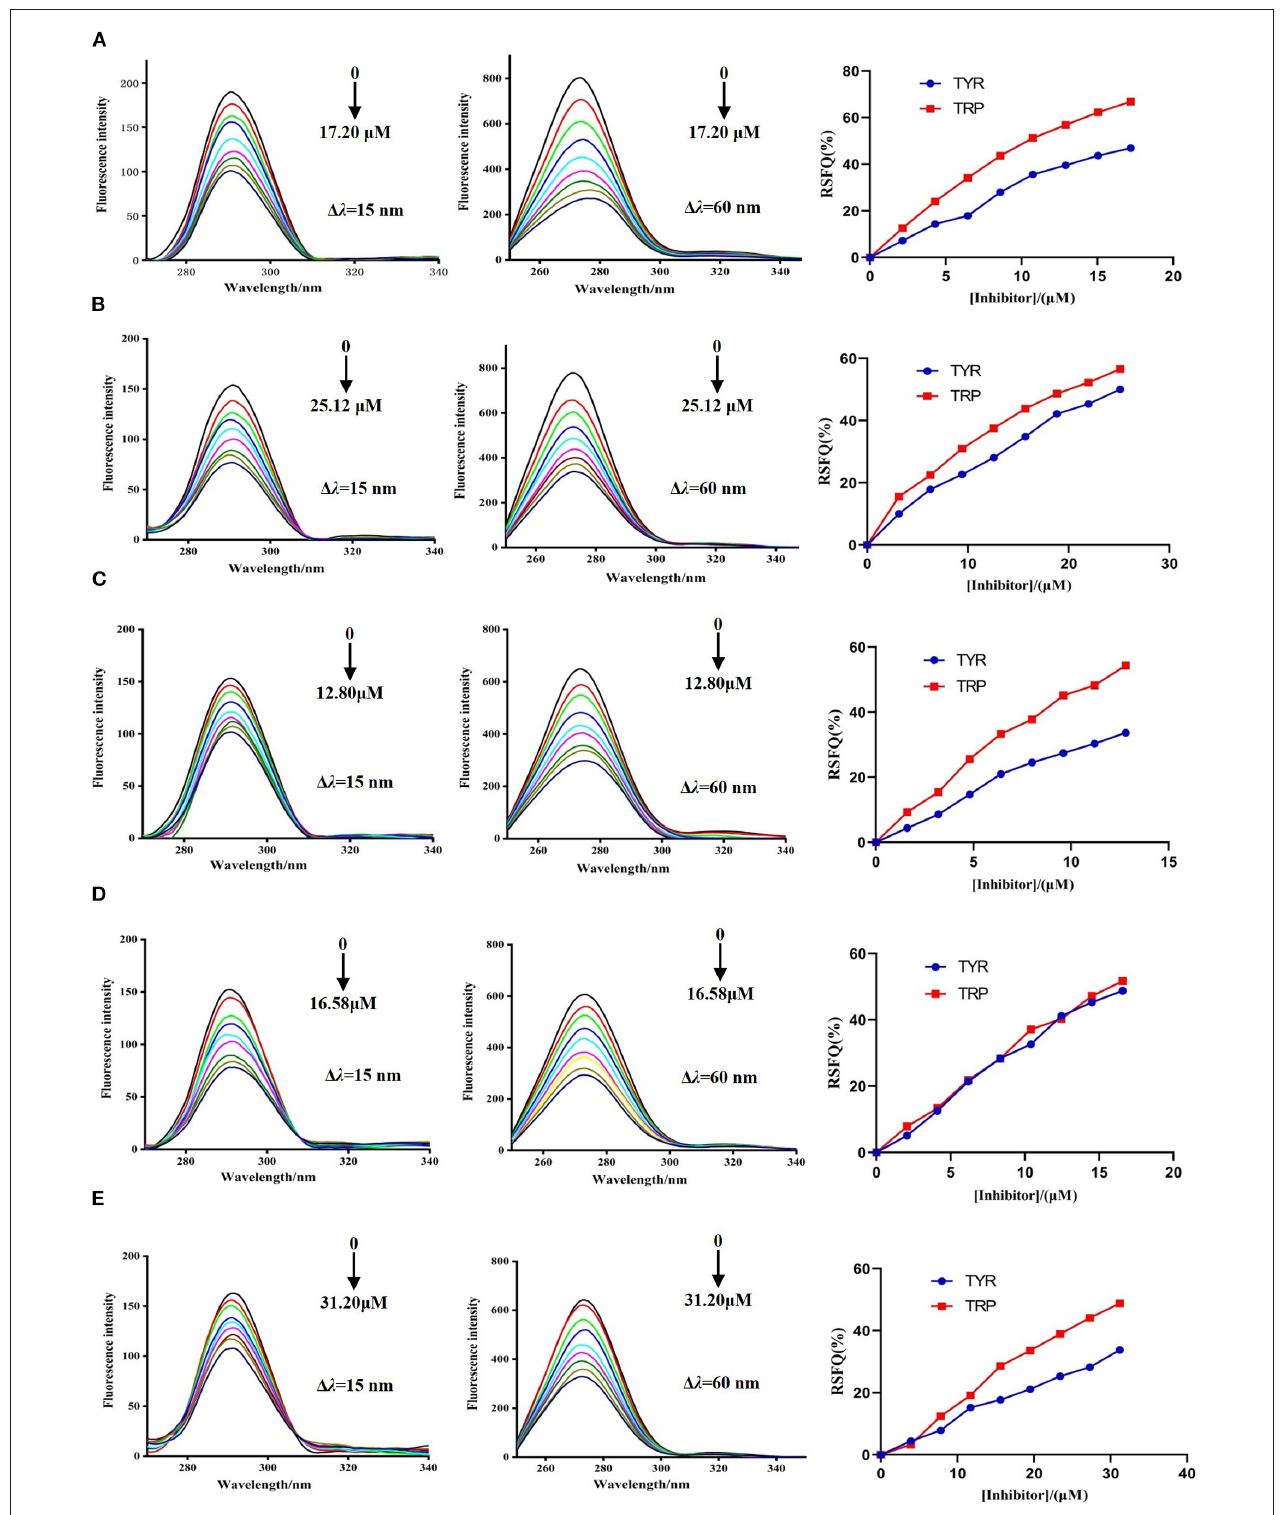
FIGURE 5 | The synchronous fluorescence spectra of DPP-4 and RSFQ values in the absence and presence of hyperoside (A) , myricetin (B) , narcissoside (C) , cyanidin 3-O-glucoside (D) , isoliquiritigenin (E) at different concentrations.